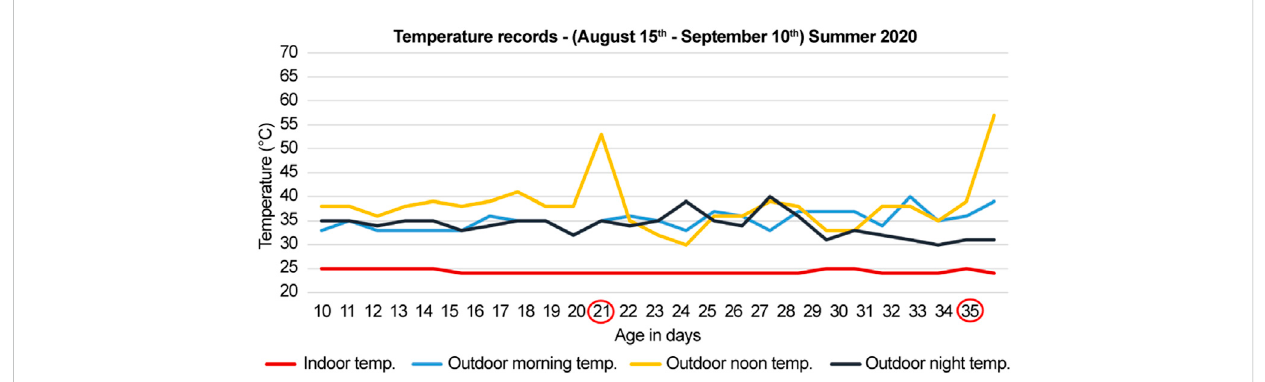
FIGURE 1 Temperature records for summer of 2020 (months of August and September). The documented temperature during the morning, noon, and night for the control (indoor) and heat-treated (outdoor) groups. The fi rst group was sacri fi ced at 21-days, and the second group was sacri fi ced at 35-days (circled in red). The peaks indicate direct exposure to sun at noon for 10 min before sacri fi ce of the heat-treated chickens.